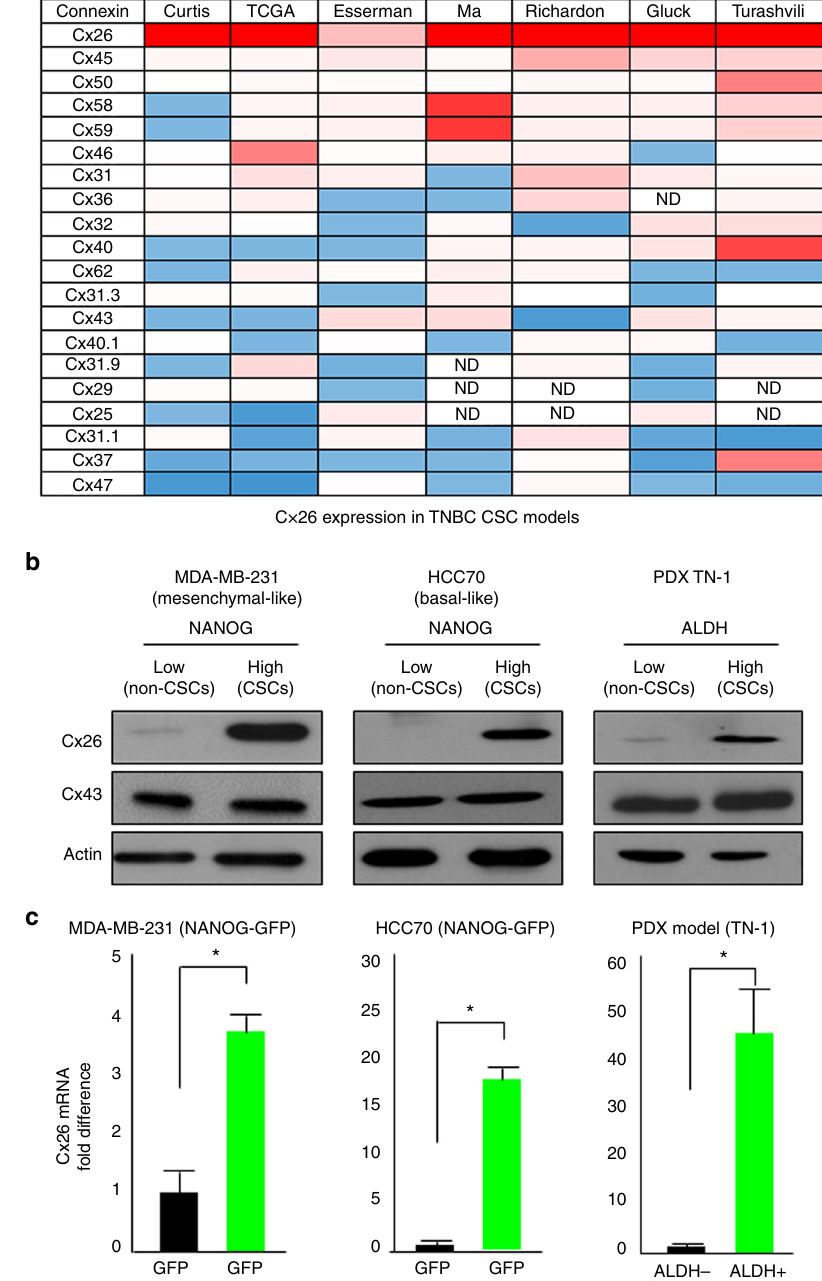
Fig. 1 Elevated Cx26 expression in TNBC tissue samples and in TNBC cancer stem cells. a Gene expression pro fi les of 20 different connexins in 2408 TNBC tissue samples were compared with those of 250 normal breast tissue samples across seven different TNBC-normal datasets using the Oncomine TM (Compendia Bioscience, Ann Arbor, MI, USA) database (http://www.oncomine.org/). b Cell lysates from CSCs enriched from two TNBC cell lines of different subtypes and from a TNBC PDX were probed with anti-Cx26 and anti-Cx43 antibodies. The NANOG-GFP reporter was used to enrich CSCs from MDA-MB-231 (mesenchymal-like) and HCC70 (basal-like) cells, and PDX TN-1 CSCs were enriched according to ALDH activity. Actin was used as a loading control. c mRNA expression was determined by qPCR and compared between cancer stem cells (CSCs) and non-CSCs enriched from MDA-MB- 231 and HCC70 cells using the NANOG-GFP reporter system and between those enriched from PDX TN-1 cells using ALDH activity sorting (ALDEFLUOR assay). Actin was used as a normalization control (* p < 0.05). All the error bars indicate standard deviation. ND, not